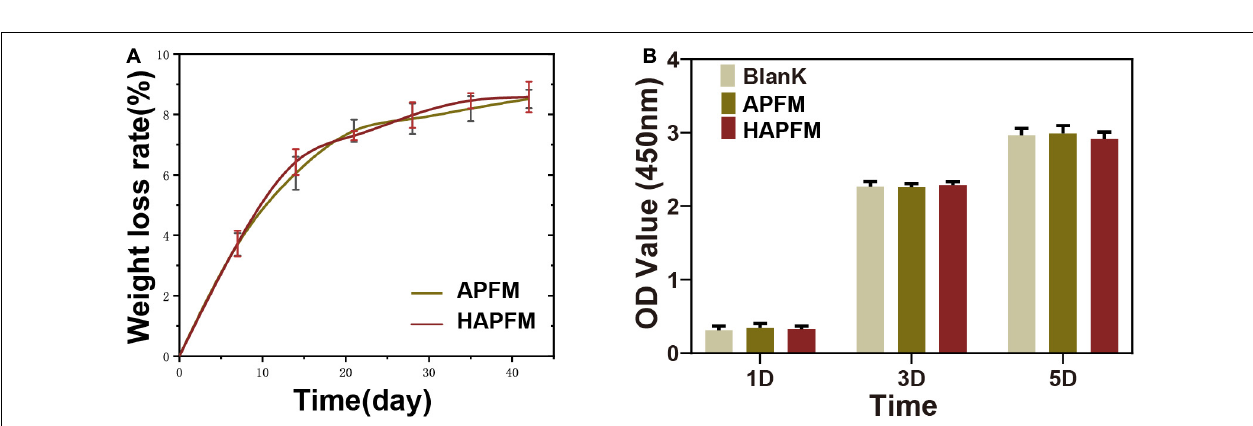
FIGURE 4 | (A) Degradation rate curve of APFMs and HAPFMs. (B) OD value of RSC96 cells detected by CCK-8 method. There were no statistically significant differences in OD values in three groups at each time ( n = 5, p > 0.05). APFMs, aligned poly ( L -lactic acid) fiber mats; HAPFMs, highly aligned poly ( L -lactic acid) fiber mats; OD, optical density; CCK-8, Cell Counting